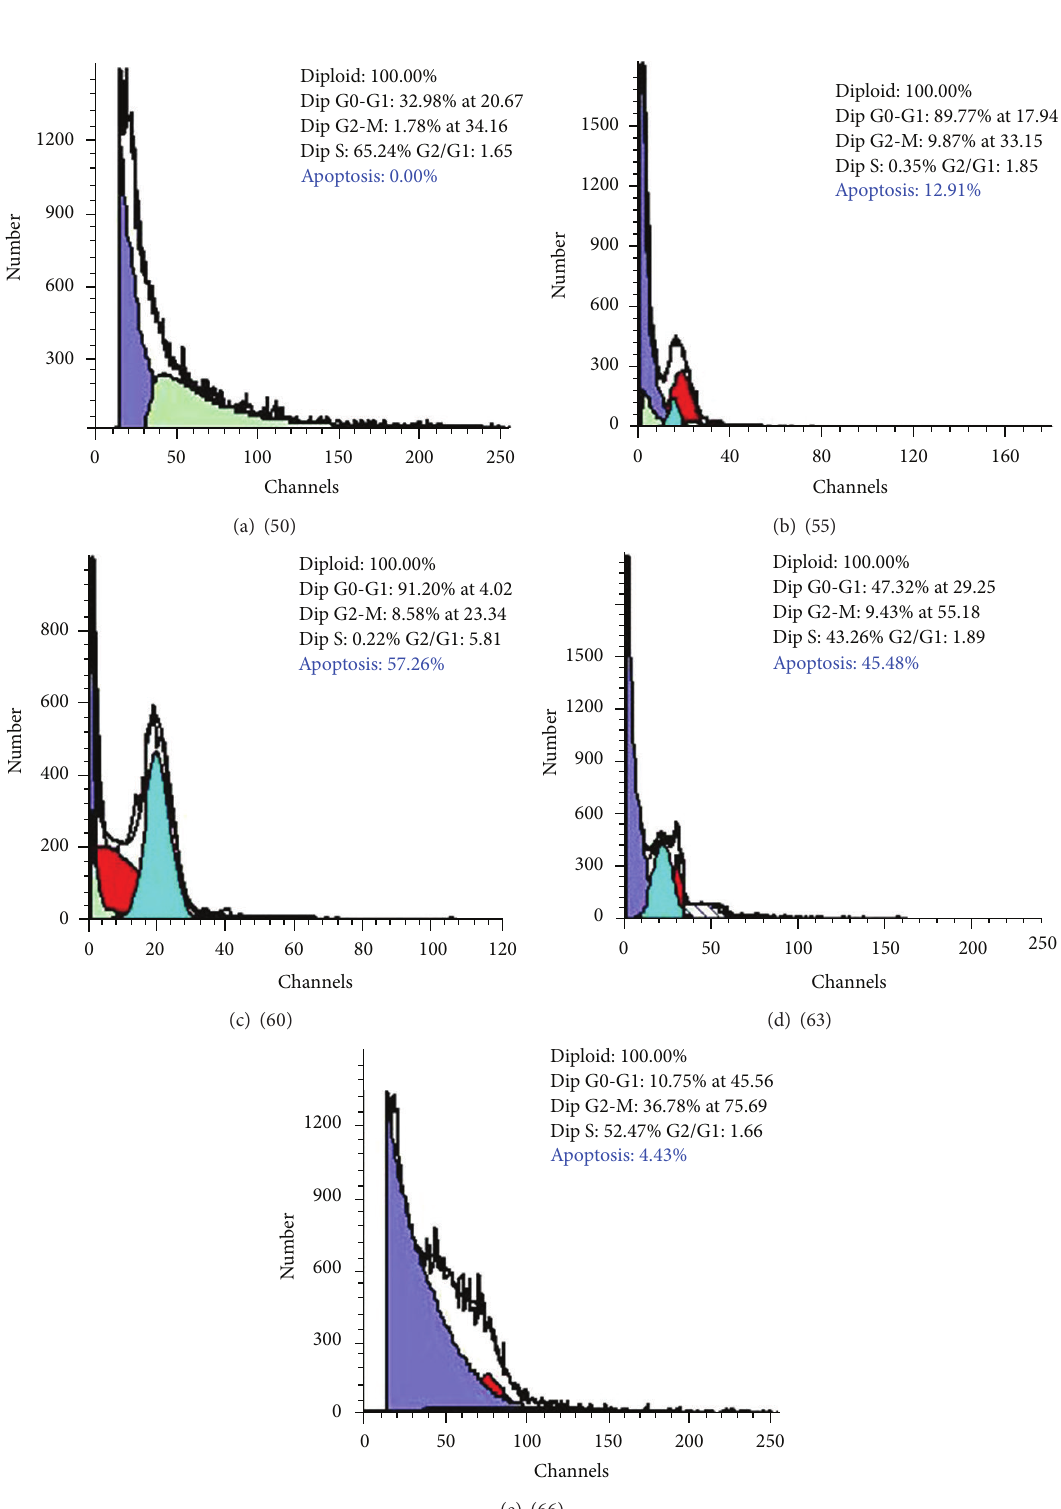
Figure 8: Computerized cell cycle analysis (flow cytometry) for apoptosis in the small intestinal cells during different developmental stages (50, 55, 60, 63, and 66, resp.) of the toad Bufo regularis